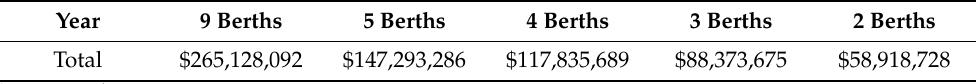
Table 8. Estimating the added value of port services users from 2020 to 2049 (unit: U.S.